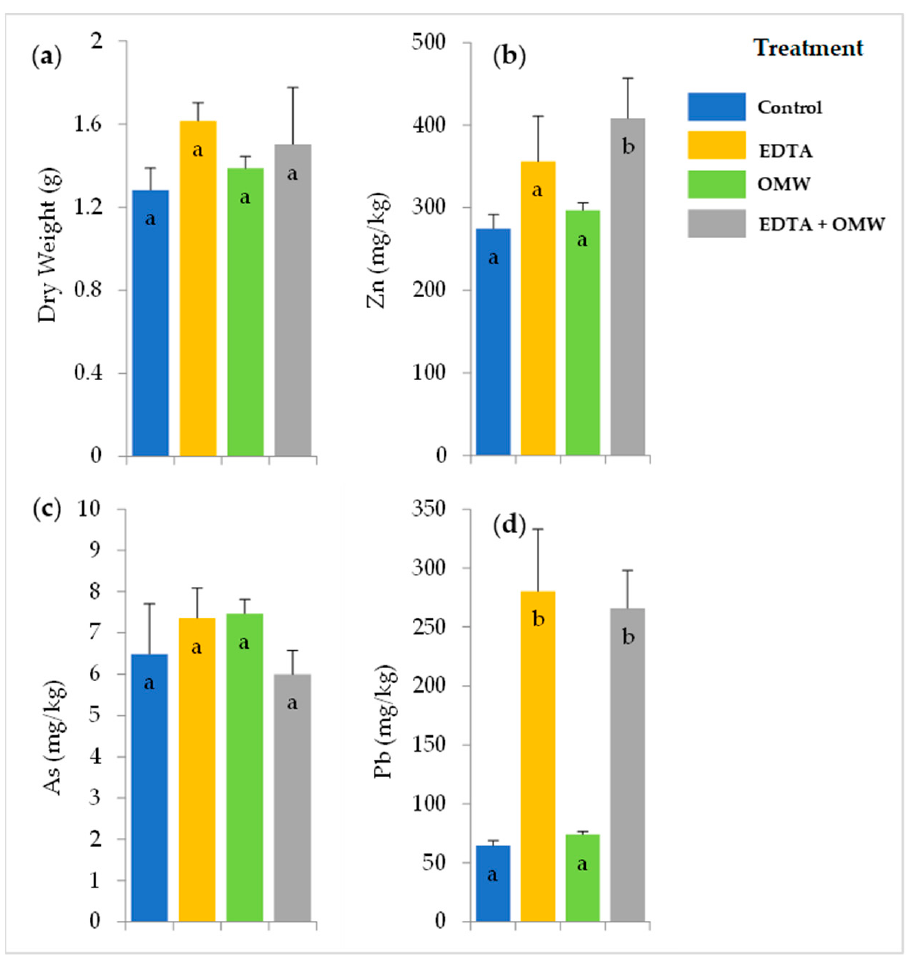
Figure 1. ( a ) Aboveground biomass (dry weight) of H. annuus and respective ( b ) Zn, ( c ) As and ( d ) Pb concentrations among different treatments. The data shown are the mean values of six replicates. The error bars represent the standard error of the mean at the 95% confidence level ( p ≤ 0.05). Comparisons were performed by Tukey’s HSD test ( p ≤ 0.05) and are demonstrated with lowercase letters. The presence of a common letter between each column implies no significant difference. OMW: olive mill wastewater.